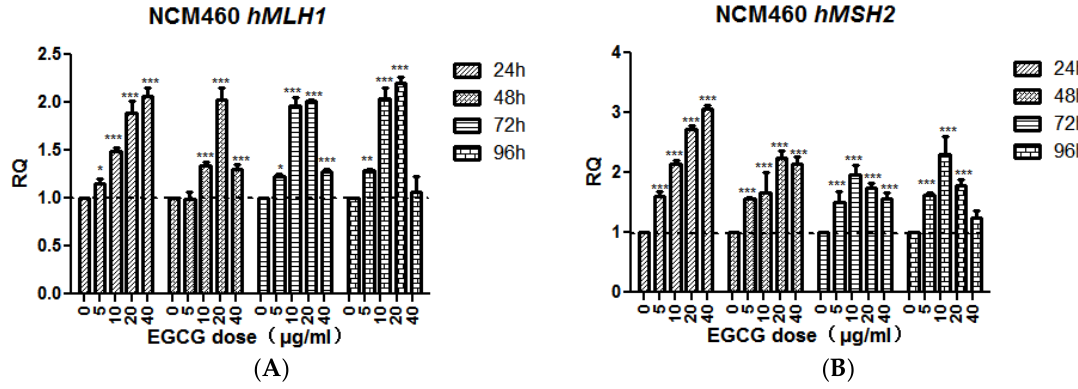
Figure 6. The effect of EGCG on the expression of hMLH1 ( A ) and hMSH2 ( B ) in the NCM460 cell line. Bars sharing different letters are significantly different. Significant differences between EGCG-treated groups and controls at each treatment interval are indicated by * p < 0.05, ** p < 0.01, and *** p < 0.001.